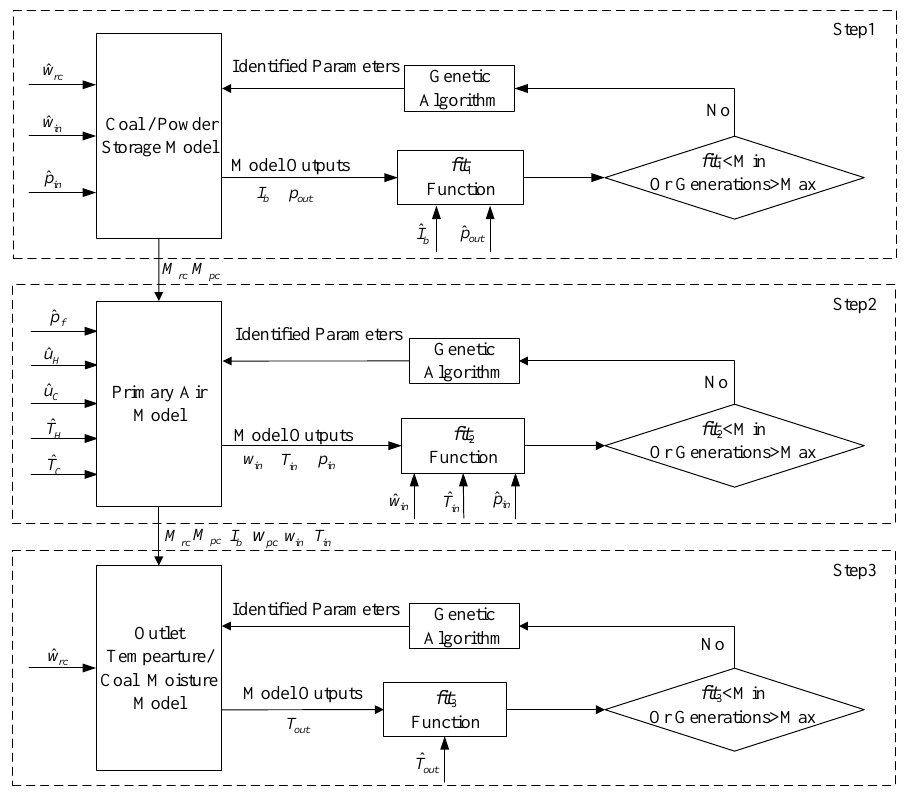
Figure 2. The identification process of model parameters. Table 1. Model parameter identification results.